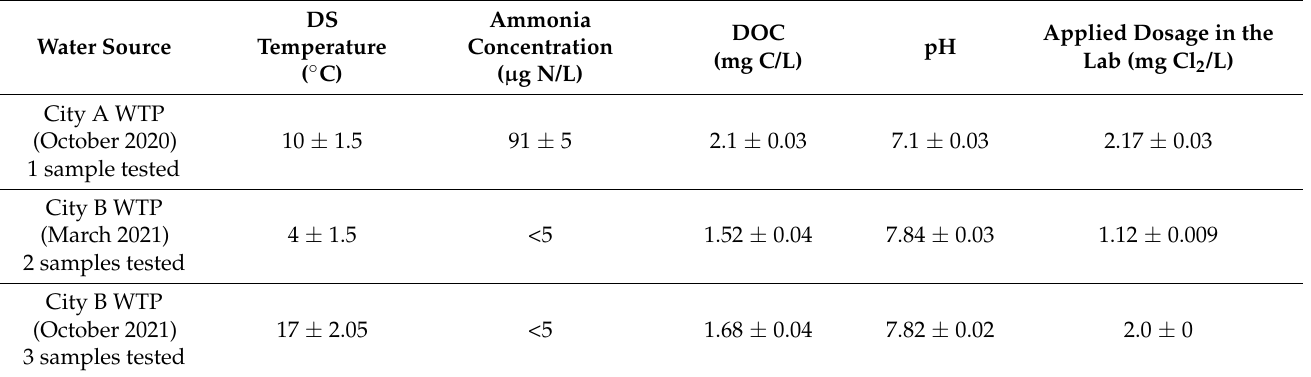
Table 1. Characteristics of the water samples (average ± standard deviation) taken from cities A and B.